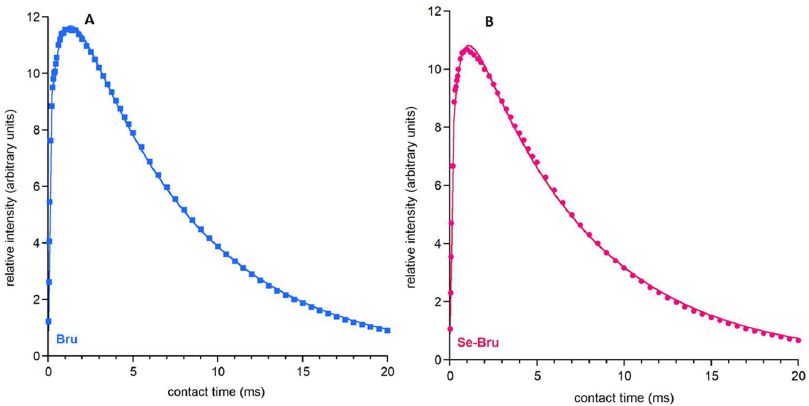
Figure 4. 1H → 31P CP MAS NMR kinetics of the studied materials: Bru ( A ) and Se-Bru ( B ).